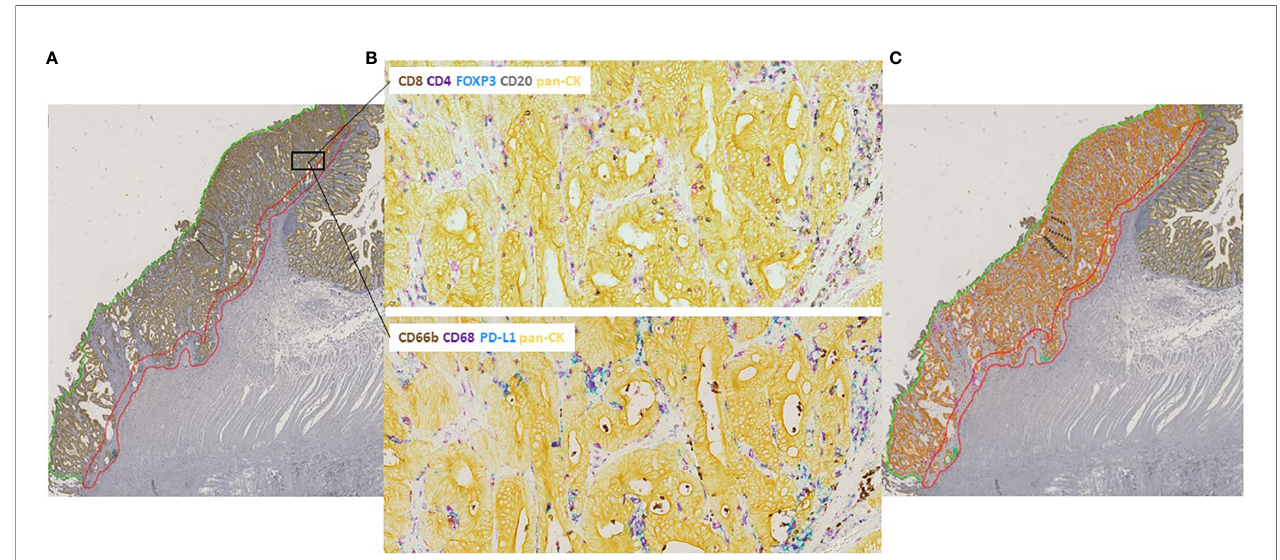
FIGURE 1 | Tumor regions and image acquisition. (A) Hematoxylin-stained whole slide of stage II colon cancer with annotated invasive margin, IM (red), and tumor center, TC (green). (B) Two multiplexed IHC-stained serial slides from the same tumor area visualizing adaptive and innate immune markers. IHC-stained slides were digitally aligned together with the hematoxylin-counterstained innate slide. (C) Automated digital analysis was applied enabling one virtual readout of the IHC-stained markers. Immune cells were quanti fi ed at the IM and TC separately and classi fi ed as either directly intra-tumoral or embedded in the